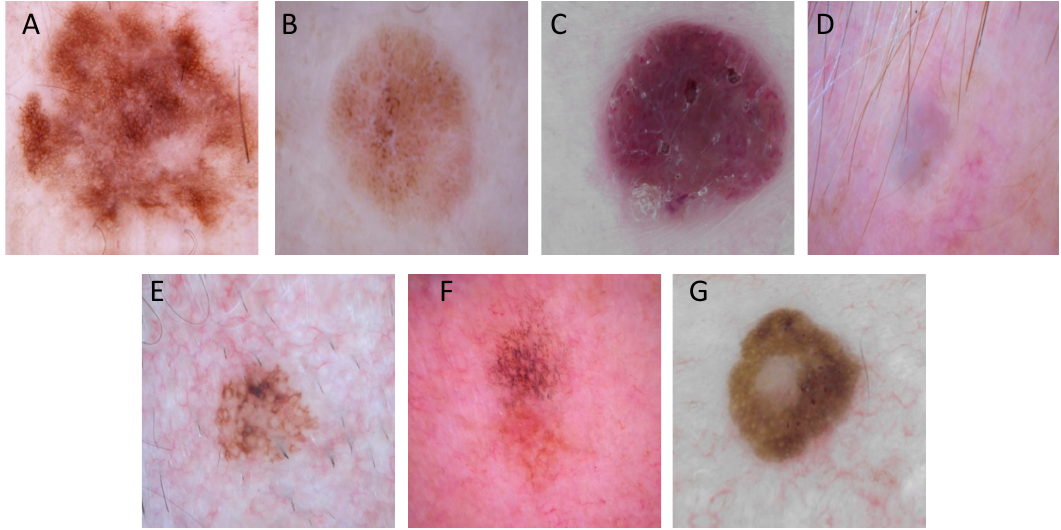
Figure 2. Examples of synthetic images generated with the information maximizing generative adversarial network (infoGAN): ( A ) melanocytic nevus; ( B ) benign keratosis; ( C ) vascular lesion; ( D ) dermatofibroma; ( E ) intraepithelial carcinoma; ( F ) basal cell carcinoma; and ( G ) melanoma.